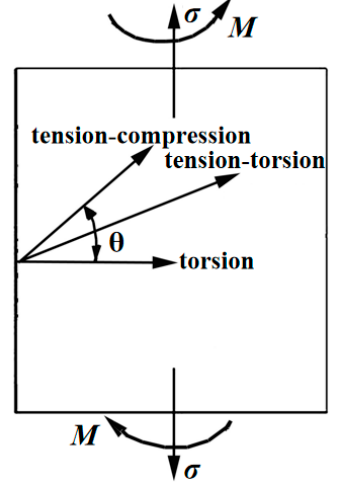
Figure 13. Critical plane of fatigue formation.